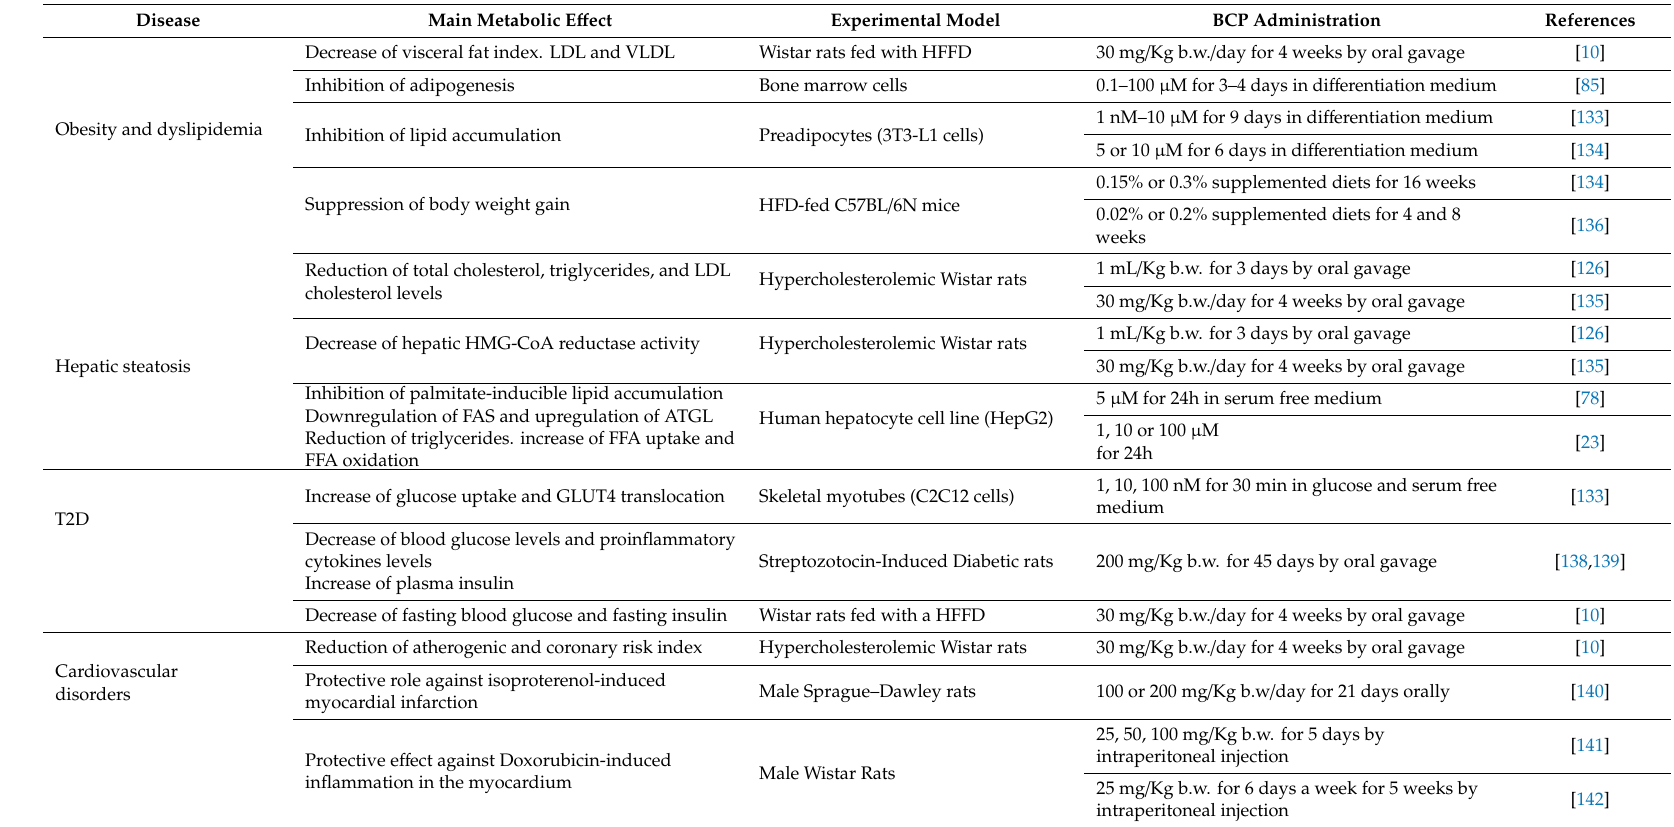
Table 1. Evidence of a role of BCP on metabolic